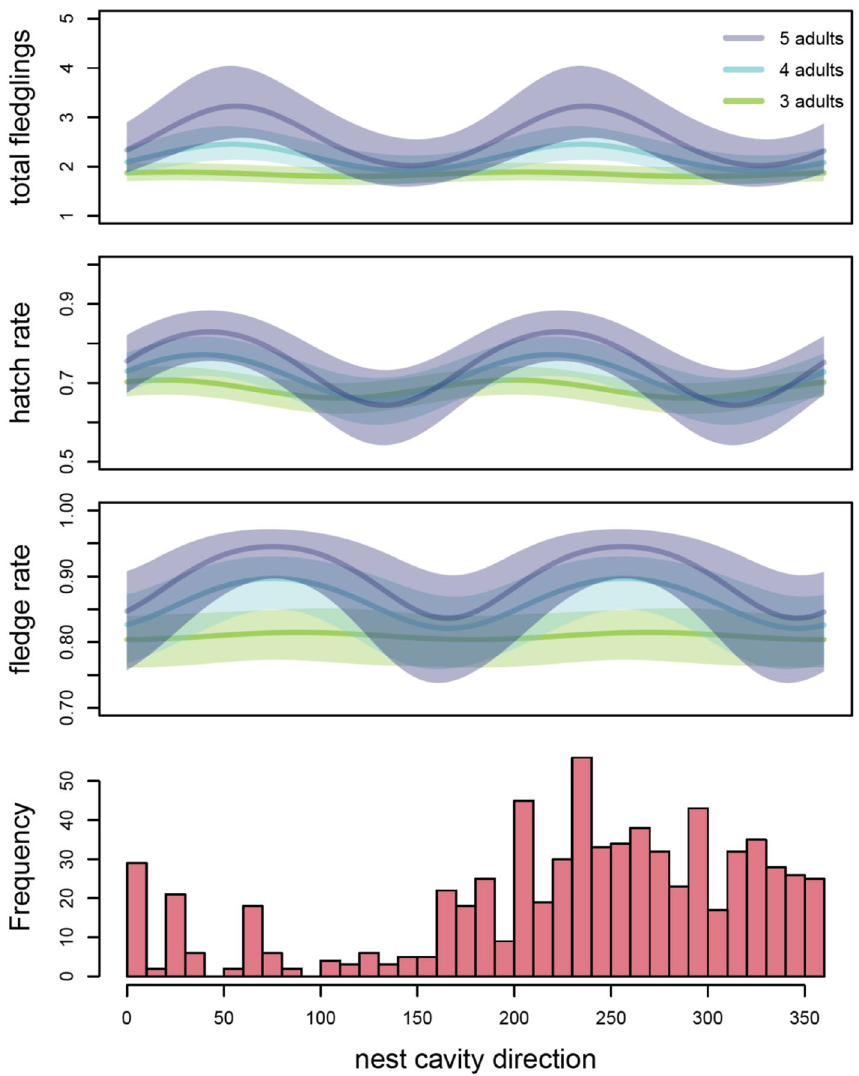
Figure 3. Nesting success of Red-cockaded Woodpeckers predicted by cavity direction (in degrees, x-axis) and the number of adult birds in the breeding group (by color). Top panel shows predicted total number of fledglings produced. Hatch rate is the predicted proportion of eggs that produced hatchlings. Fledge rate is the predicted proportion of hatchlings that will fledge. Lines represent GLMM fits for fixed effects, shading shows 95% confidence interval. GLMM details in Table 2. Bottom panel shows frequency histogram of nest cavities used (cavities used n times are counted n times)